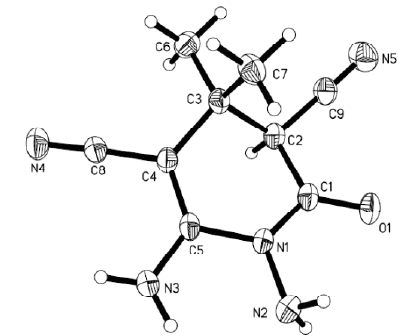
Figure 1. The crystal structure of compound 5a